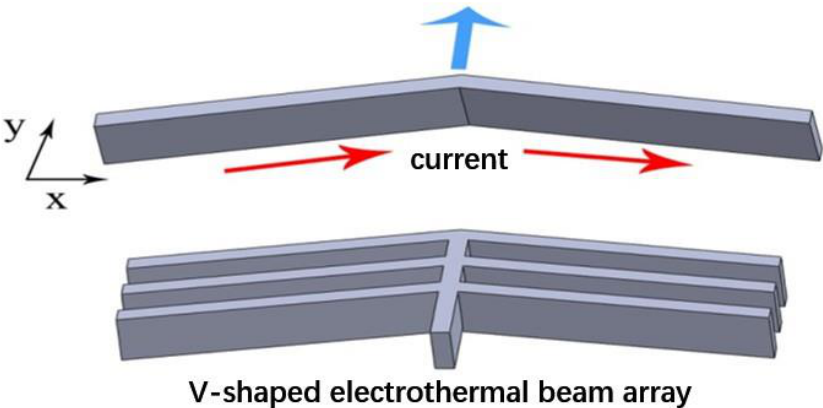
Figure 1. Device structure.